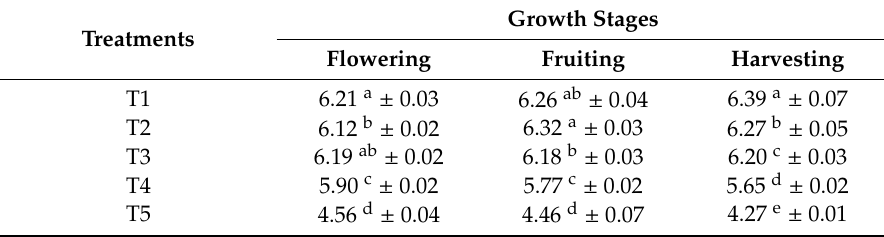
Table 5. pH of peat soils cultivated with papaya at flowering, fruiting, and fruit harvest